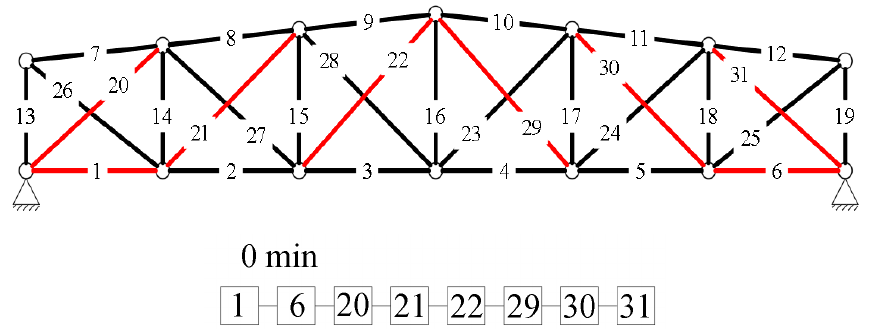
Figure 8. Statically indeterminate structure with six degrees of freedom, with two nonsliding supports (Truss 2) and corresponding cut-sets.